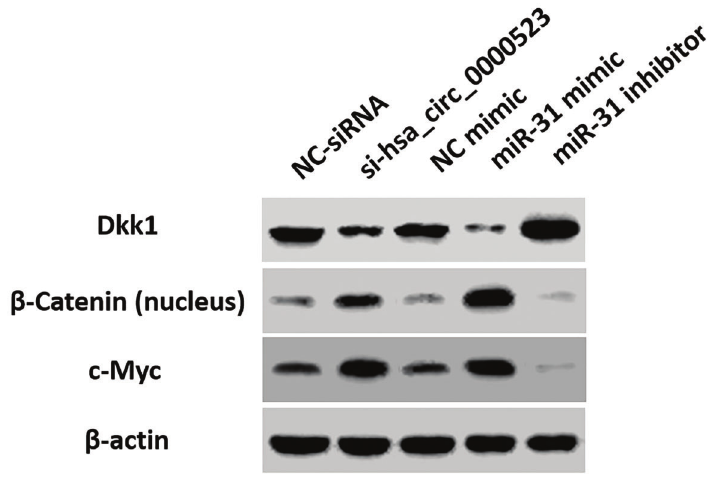
Figure 5. Hsa_circ_0000523 and miR-31 regu- lated the Wnt/ b -catenin pathway. Western blot analysis of Dkk1, b -Catenin in nucleus, and c-Myc expression in SW480 cells transfected with si-circ_0000523, miR-31 mimic, miR-31 inhibitor individually. b -actin was used as internal